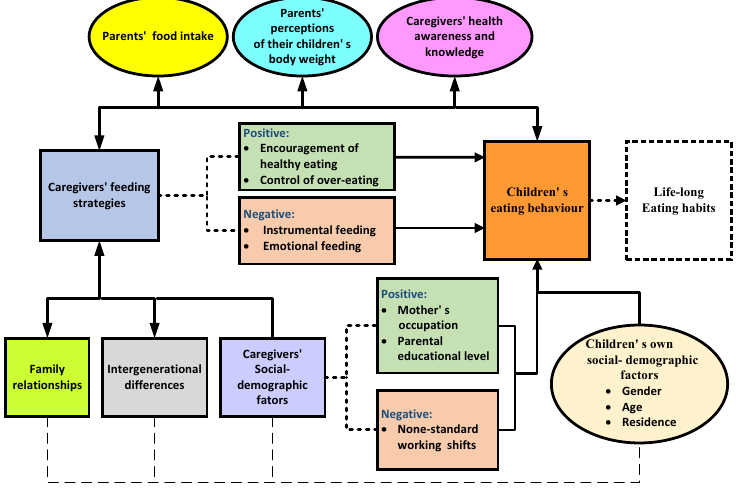
Figure 2. Relationships between the seven themes and eating behaviours of